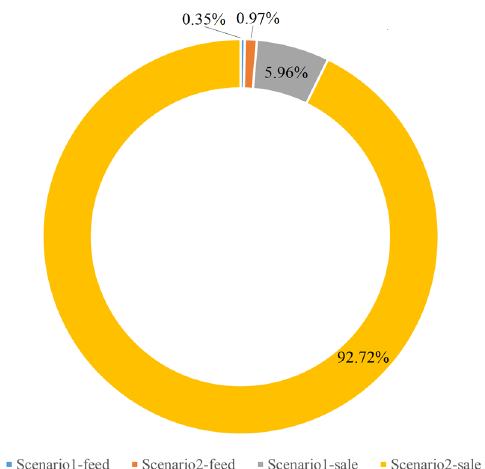
Figure 8. Distributions of stage-wise sum of stream flows for two scenarios.